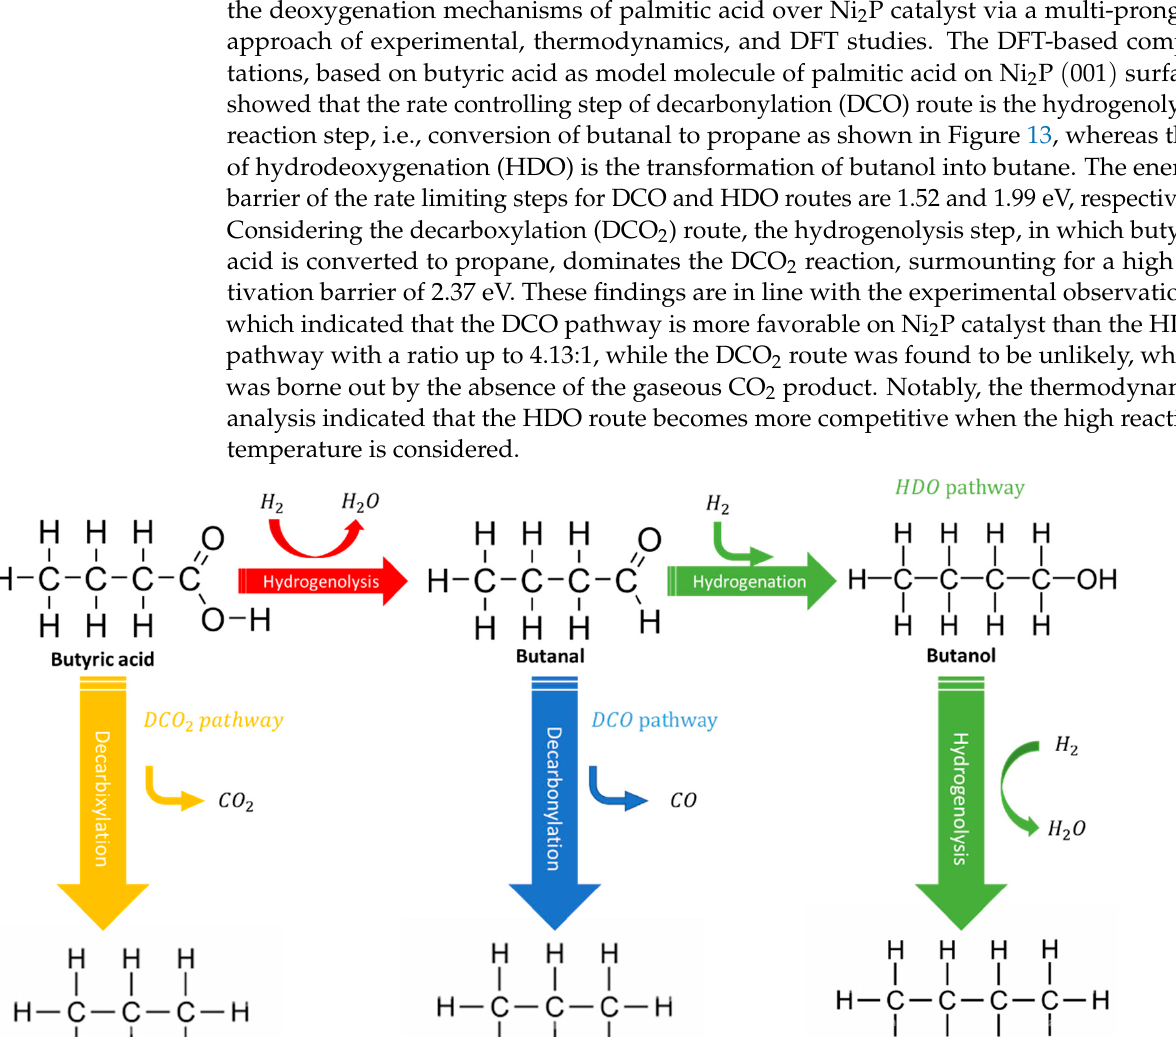
Figure 14. suggested reaction pathways for guaiacol HDO on Ni (cid:2870) P catalyst. Adapted from Ref. [169]. A fundamental understanding of the reaction mechanism, at the atomistic level, is of prime importance to unravel the rate-limiting steps for the hydrodeoxygenation reaction on TMPs catalysts. Jain et al. [170] investigated the phenol HDO on ternary phosphide catalytic surfaces, namely FeMoP, RuMoP, and NiMoP, using experimental and compu- tational approaches to determine products distribution and C–O bond scission pathways. The results revealed that the FeMoP surface promotes a direct deoxygenation route,